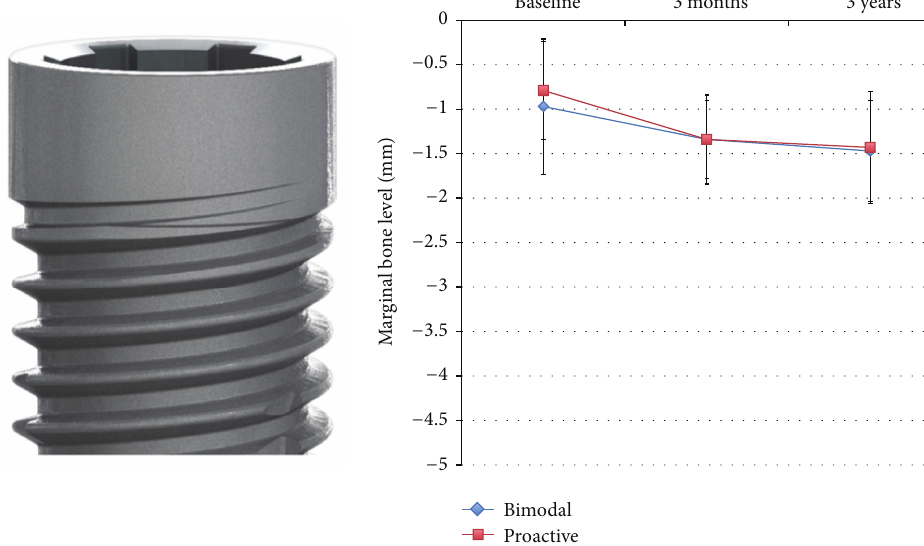
Figure 6: Showing results from marginal bone level measurements at bimodal and proactive